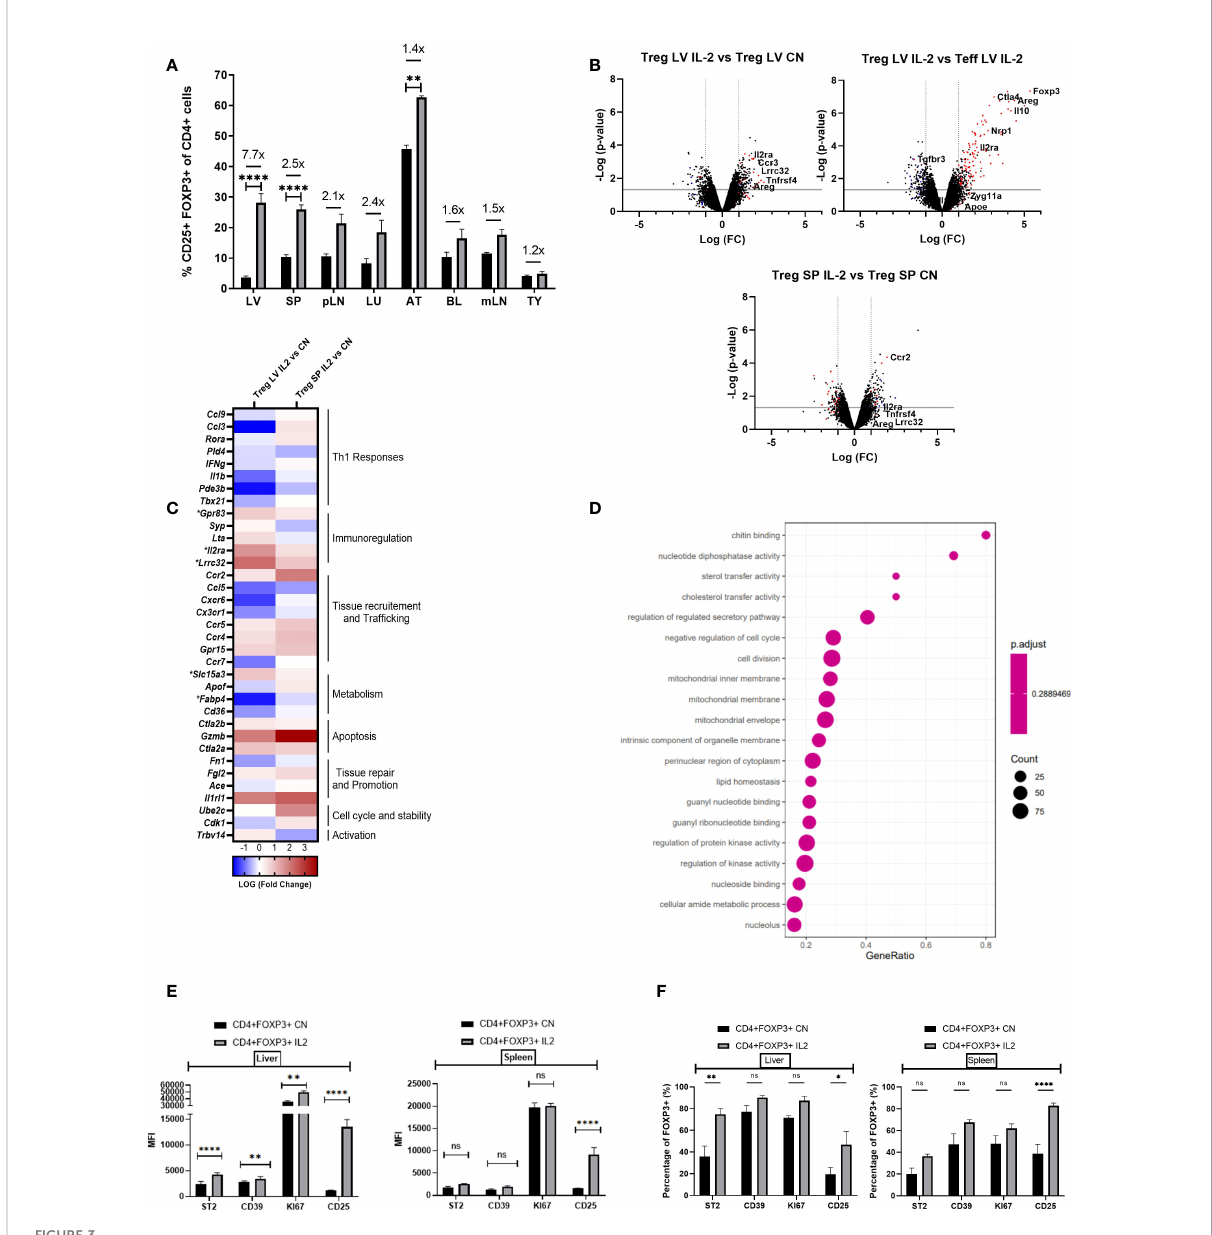
FIGURE 3 IL-2 administration increases Foxp3+ cells in the liver and enhances Treg signature transcriptional characteristics. (A) Quanti fi cation of the proportion of Foxp3+ CD4+CD25+ cells in the liver (LV) (n>8), spleen (SP) (n>8), peripheral lymph nodes (pLN), lung (LU), adipose tissue (AT), blood (BL), mesenteric lymph nodes (mLN) and thymus (TY) (n=4). (B) Volcano plot shows difference in the transcriptome pro fi le of intra- hepatic Tregs and T-effectors when IL-2 is administered in Foxp3YFP mice (n=3) using normalised p-value versus fold change of all 20515 genes and splenic “ Treg signature ” is de fi ned by up-regulated (red) and down-regulated (blue) genes above p-value of 0.05 and Fold change 2. (C) Heatmap exhibits differences in the expression of pre-de fi ned differentially expressed genes relevant to Treg function, tissue residency, tissue repair and metabolism between intra-hepatic and splenic Treg population following IL-2c administration, and the signi fi cance is determined above p-value of 0.05 and Fold-change 2 and represented by a *. (D) Gene set enrichment analysis of IL-2c treated intra-hepatic Tregs compared with the intra-hepatic Tregs in homeostasis. Dot plot shows the top 20 up-regulated GO pathways of biological processes, molecular functions and cellular components with an FDR adjusted q-value of 0.020506. Dot size represents the number of genes enriched in the pathway, and gene ratio represents the ratio of the count of core enrichment genes to count of pathway genes. (E, F) Flow cytometric analysis of the effect of IL-2 administration on the previously de fi ned differentially expressed transcripts of CD4+Foxp3+ cells in liver and spleen tissue, expressed as MFI and percentage. Signi fi cance was determined by ordinary one-way ANOVA with Sidak ’ s multiple comparison test for (A) and two-way ANOVA with Tukey multiple comparison test for (E, F) and the values are shown as the mean ± SEM. For B-D, p<0.05 and Fold Change >2. MFI, geometric mean fl uorescence intensity. Ns, non-signi fi cant *P < 0.05, **P < 0.01 and ****P <